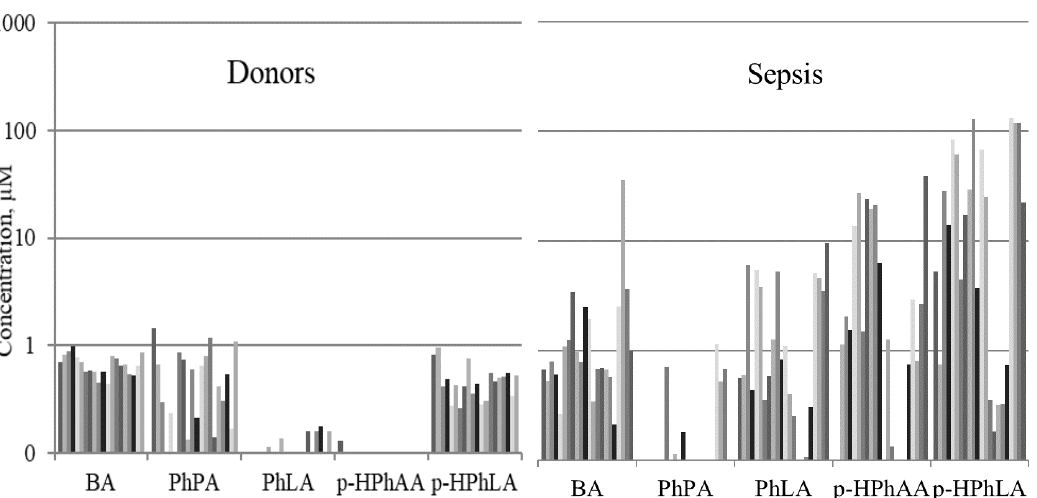
Figure 1. Concentrations of phenylcarboxylic acids (µM) in the serum samples of healthy controls ( n =